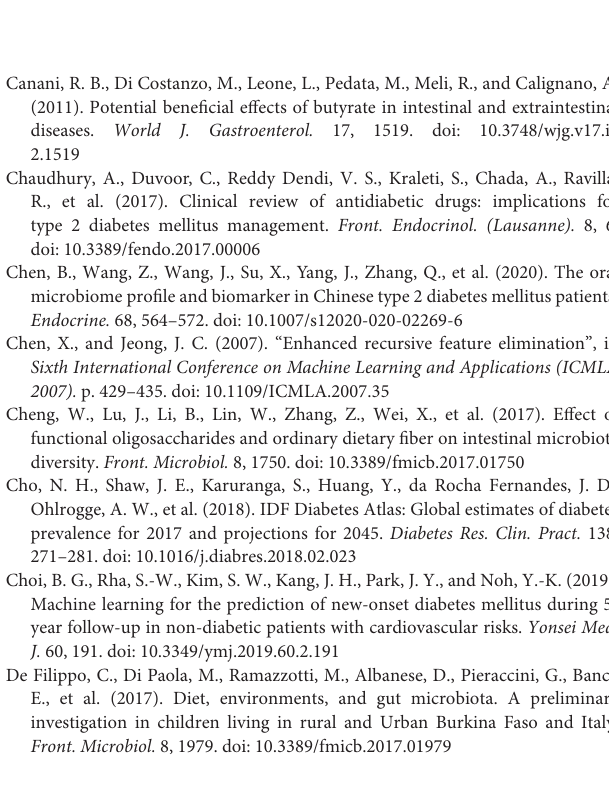
level of studied samples. Supplementary Figure S2 | Dominant bacterial community between two groups (T2D and NGT). Differentially abundant OTUs within two groups are represented in Dotplot using ALDEx2. Dotplot represents class level taxonomy on the left side and genus level on the right side. The size of each dot (0, 5, 10, 15) represents centered log-ratio (clr) – transformed sequence